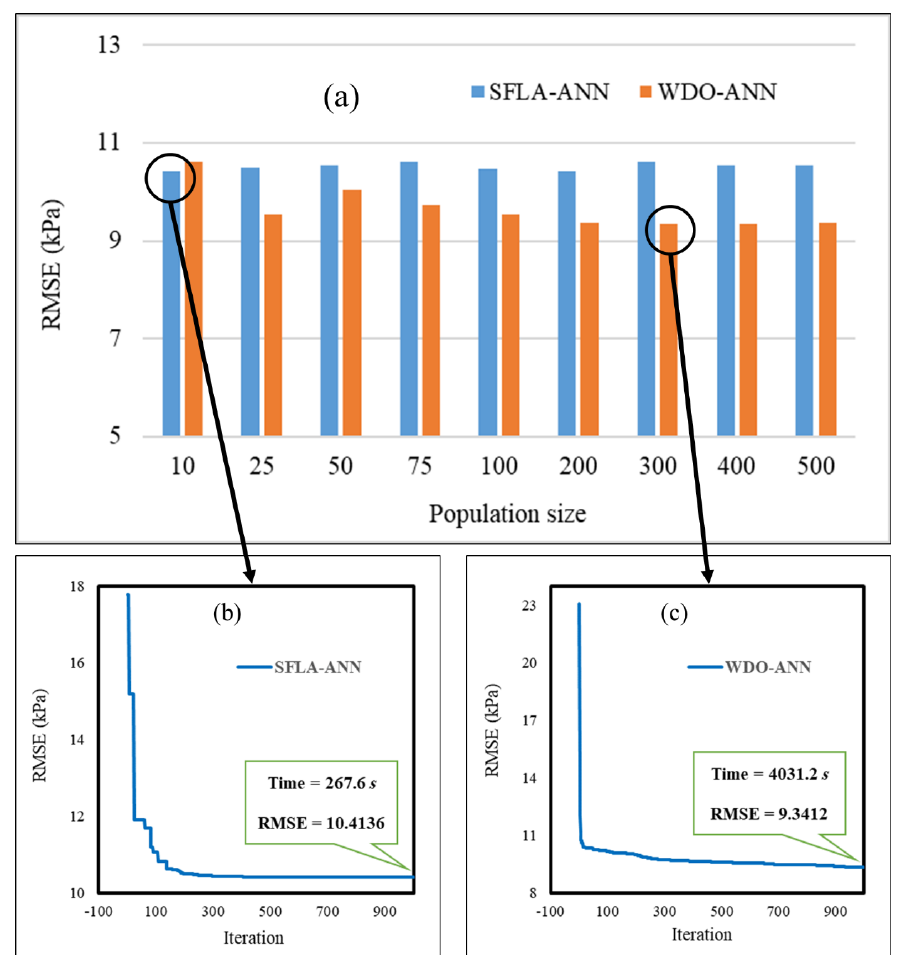
Figure 5. ( a ) The results of the executed sensitivity analysis; ( b , c ) the convergence curves of the elite SFLA – artificial neural network (ANN) and wind-driven optimization (WDO) – ANN, respectively.